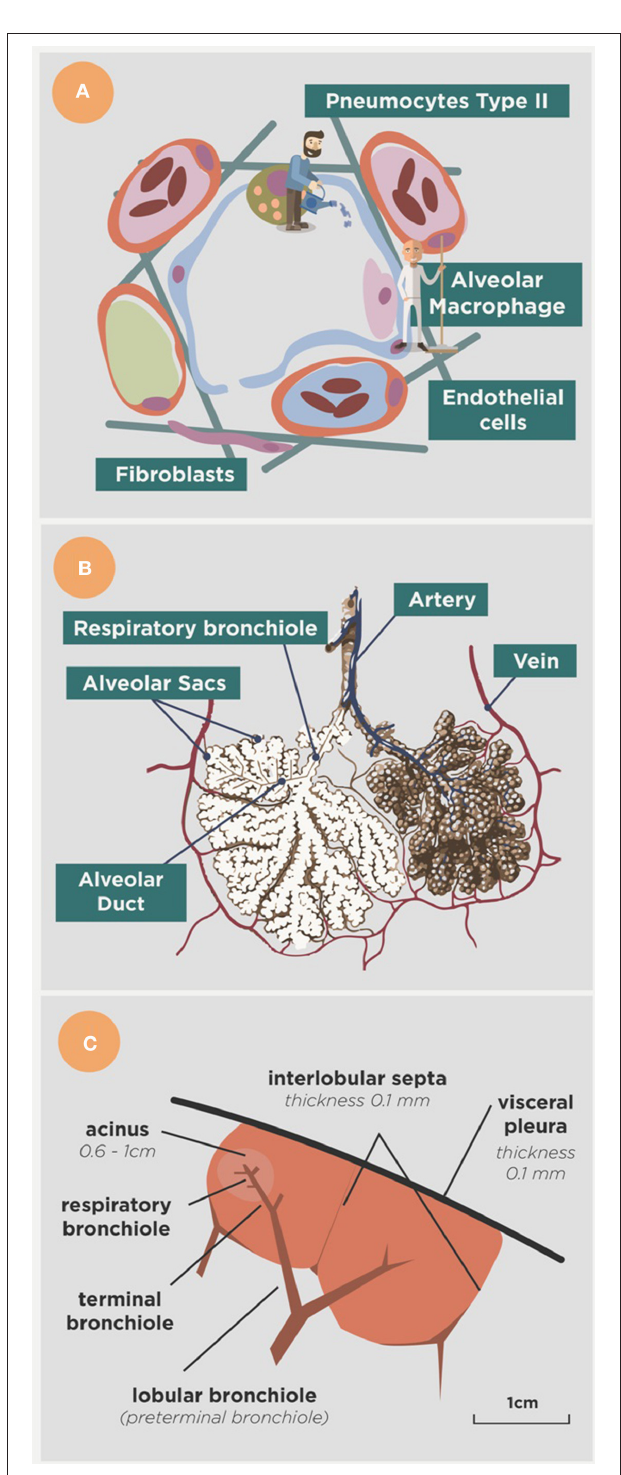
FIGURE 2 | Anatomical approach to the alveoli. (A) Shows the main actors in the alveoli, namely the alveolar macrophage (the cleaner), the type II pneumocytes (the gardener) that form the surfactant, the epithelial cells that limit the space and the endothelial cells that limit the capillary net. Arterialvesselsareshowninred,venousvesselsinblueandlymphaticvesselsin